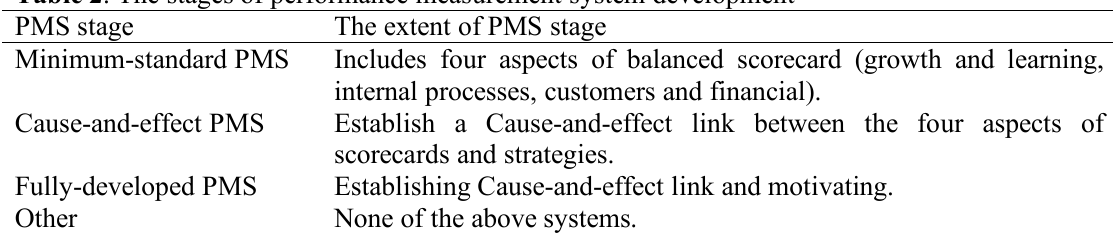
Table 2 . The stages of performance measurement system